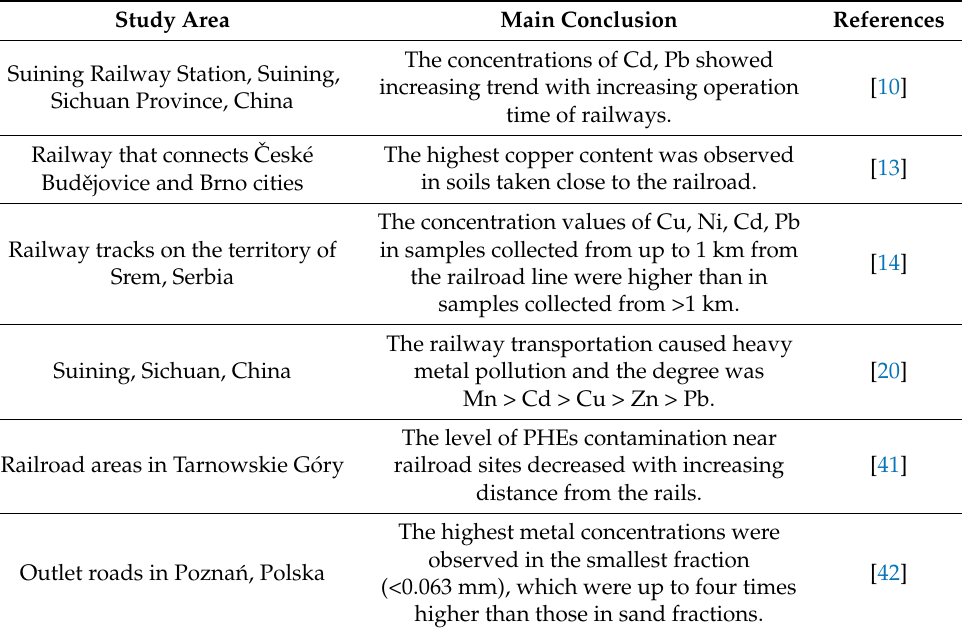
Table 3. Representative research similar to this